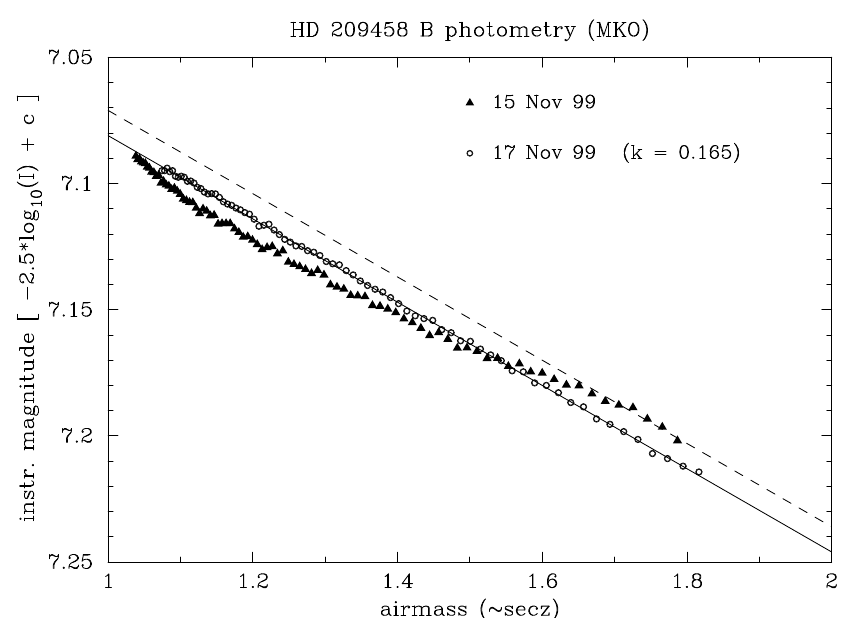
Fig. 3. Instrumental magnitude versus airmass plots for HD 209458 on 15 (on transit) and 17 (off transit) November 1999. The solid line is a linear airmass model fit to the off transit data and the dashed line is explained in the text.